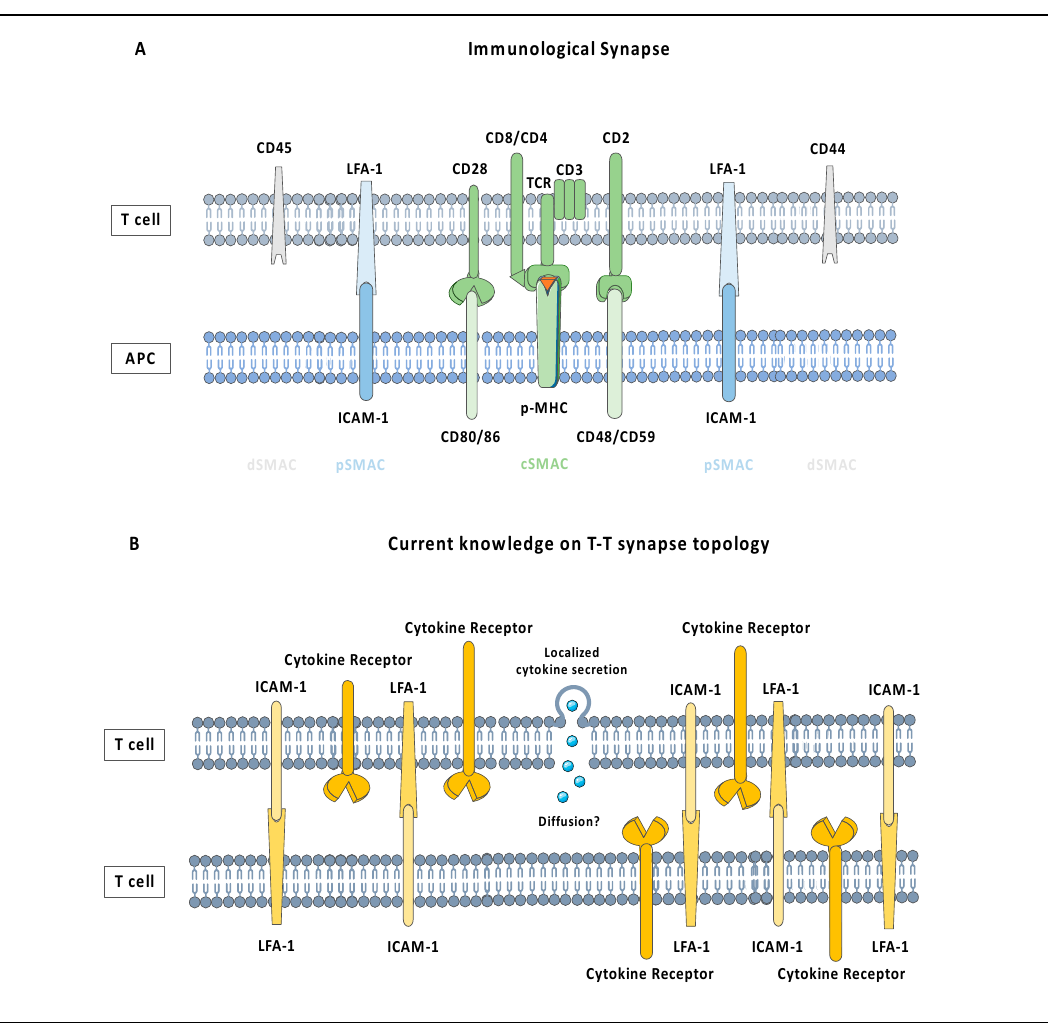
Figure 1. Comparison between the immunological synapse formed between an antigen-specific T cell and antigen-presenting cells (APC) ( A ) and the T-T cell synapse ( B ). While the T-APC immunological synapse is characterized by a high level of membrane organization, the T-T synapse does not show a clear structural organization. Cytokines are secreted at the centre of T-T synapses, but it is unclear if they di ff use into the cleft between the cells or are immediately taken up by receptors, which have been observed to be enriched at contact sites, but without being organized into distinct